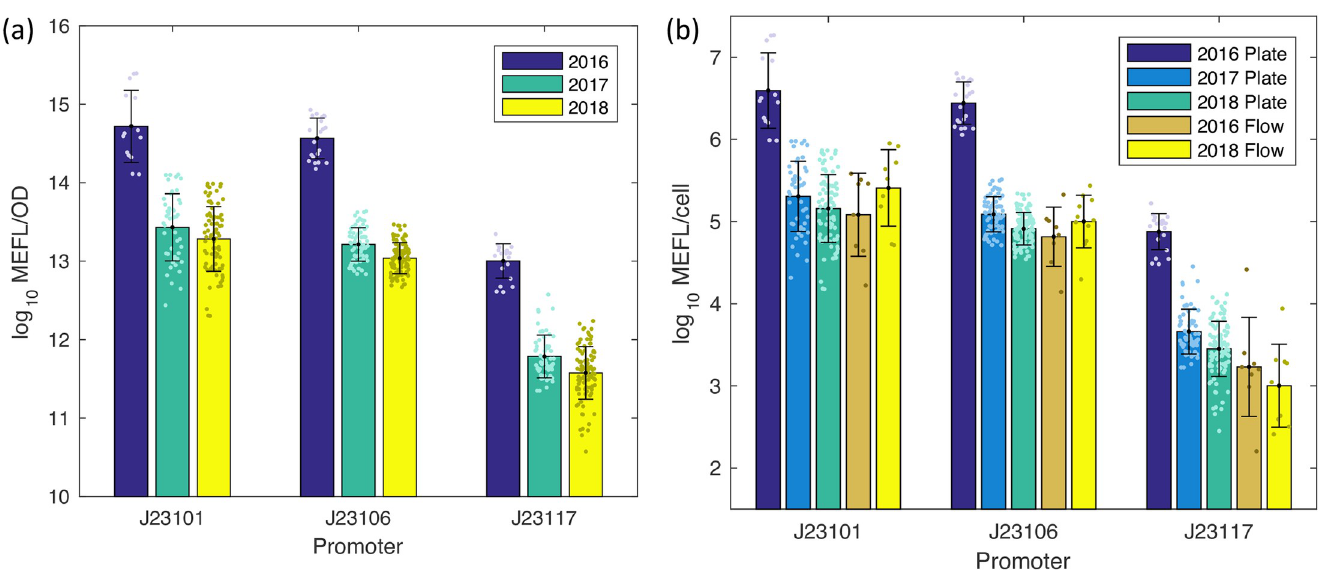
Fig 4. Comparison of measured fluorescence of test genetic constructs. Comparison of plate reader data in MEFL/OD units (a), and both plate reader and flow cytometry data in MEFL/cell units (b). Bars show geometric mean and standard deviation; dots show values from individual teams. Team count per condition is provided in S7 File Teams Per